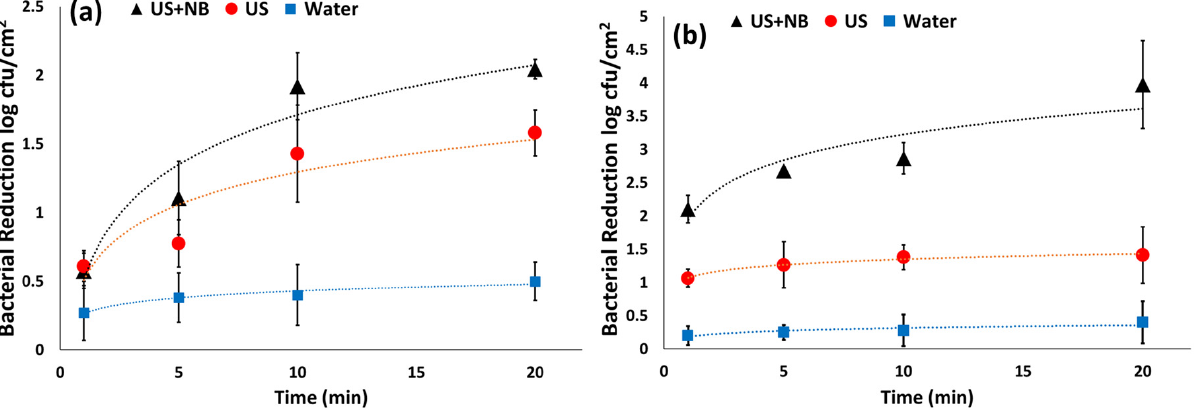
Figure 2. ( a ) L. innocua and ( b ) E. coli reduction in ultrasound (US) and nanobubbles + ultrasound (NB + US) treated spinach leaves at different exposure times.